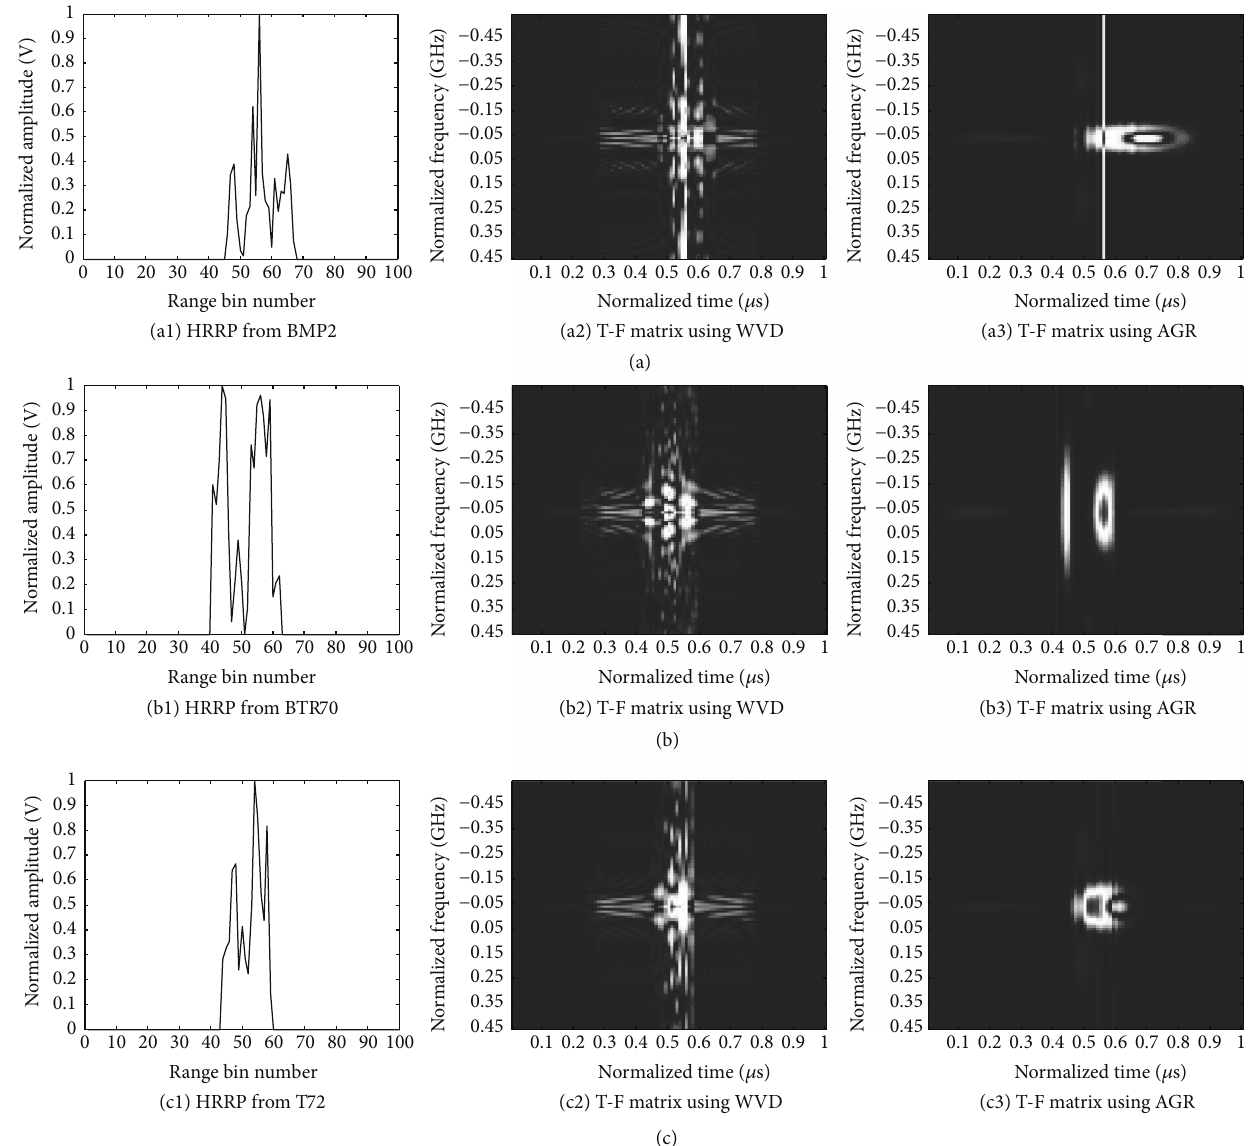
Figure 2: Comparison between T-F matrices using WVD and T-F matrices using